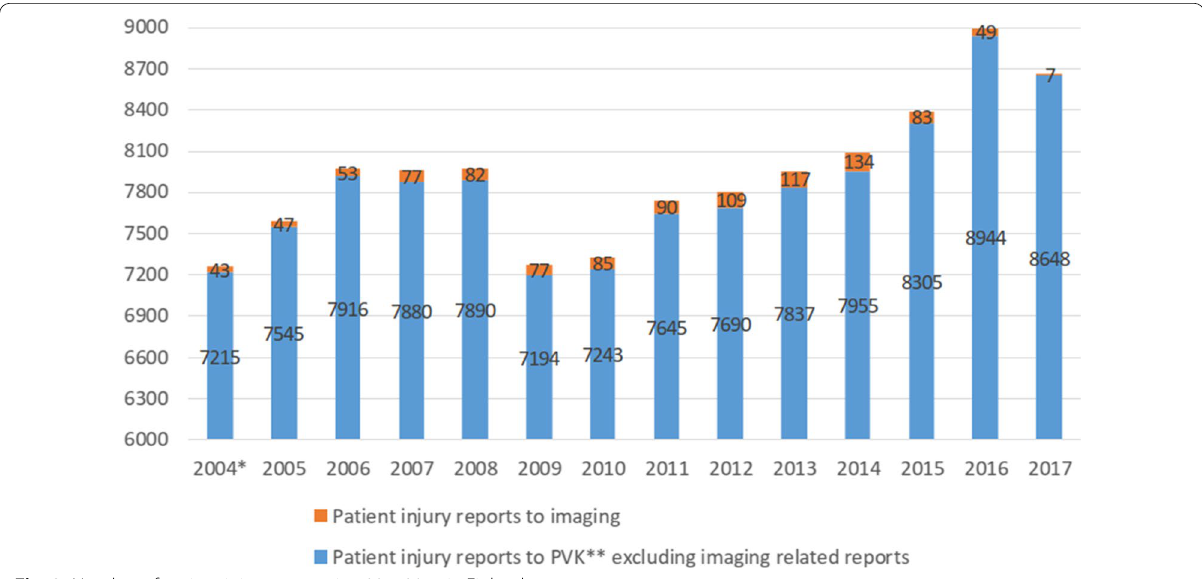
Table 1 Patient’s reasons for claims in different radiology modalities Patient’s reasons for the